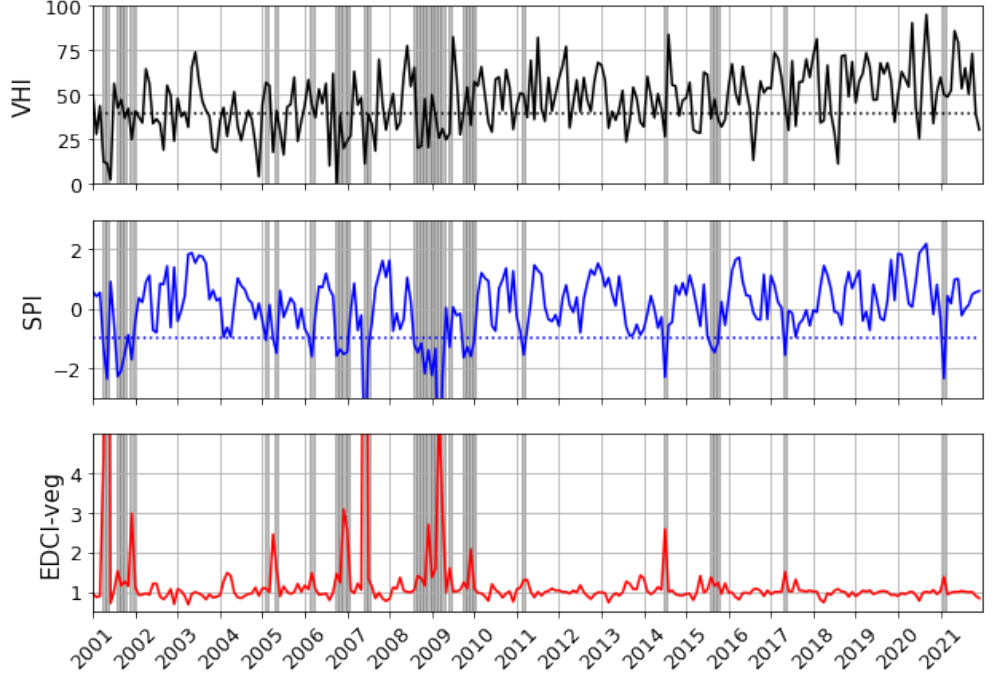
Figure 6. VHI, SPI, and EDCI-veg time series.